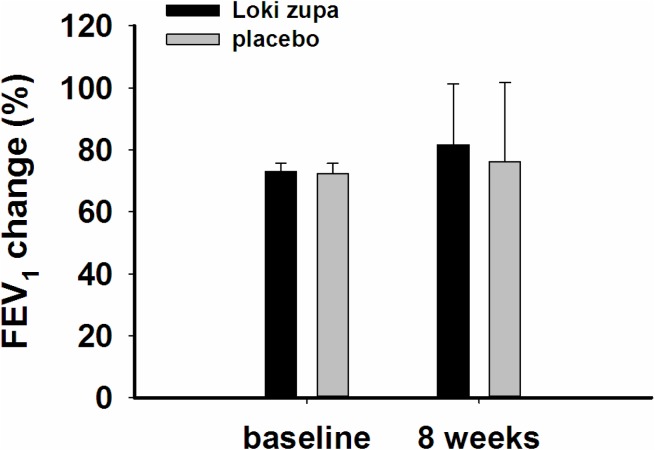
FEV1 change from baseline (p = 0.131).